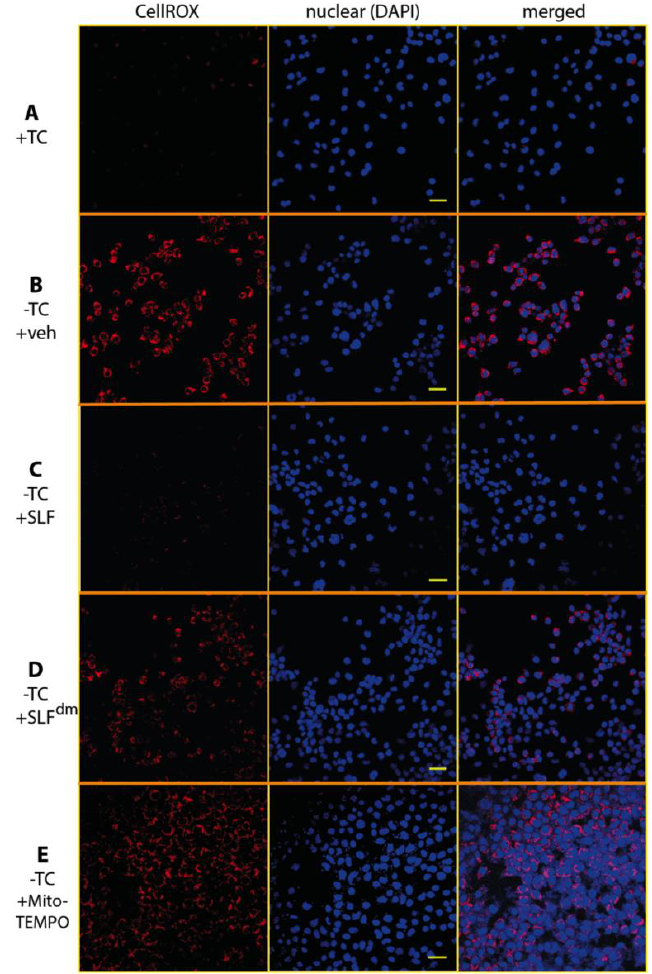
Figure 3. The nitroxide moiety of SLF has extensive ROS scavenging properties in cultured neuronal cells induced to overexpress the amyloid precursor protein (APP). Confocal microscopy images show Aβ-induced ROS signal reported by the fluorogenic dye CellRox Deep Red (red punctae in image) in MC65 human neuroblastoma cells when APP expression is turned on ( B ) relative to the control ( A ). In cells that are overexpressing APP, SLF greatly attenuates the ROS signal ( C ). SLF lacking the nitroxyl moiety ( D ) and the MitoTEMPO antioxidant ( E ) provide lower ROS scavenging activity compared to SLF. In addition to the CellROX images (left column), the DAPI nuclear stain (middle column) and the merged DAPI-CellRox images (right column) are shown. Scale bar represents 20 μm.